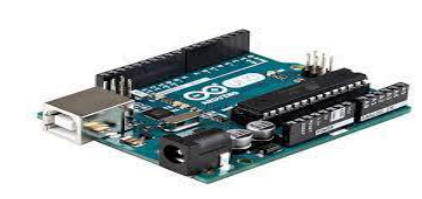
Figure 3 – Arduino Рис. 3 – Arduino